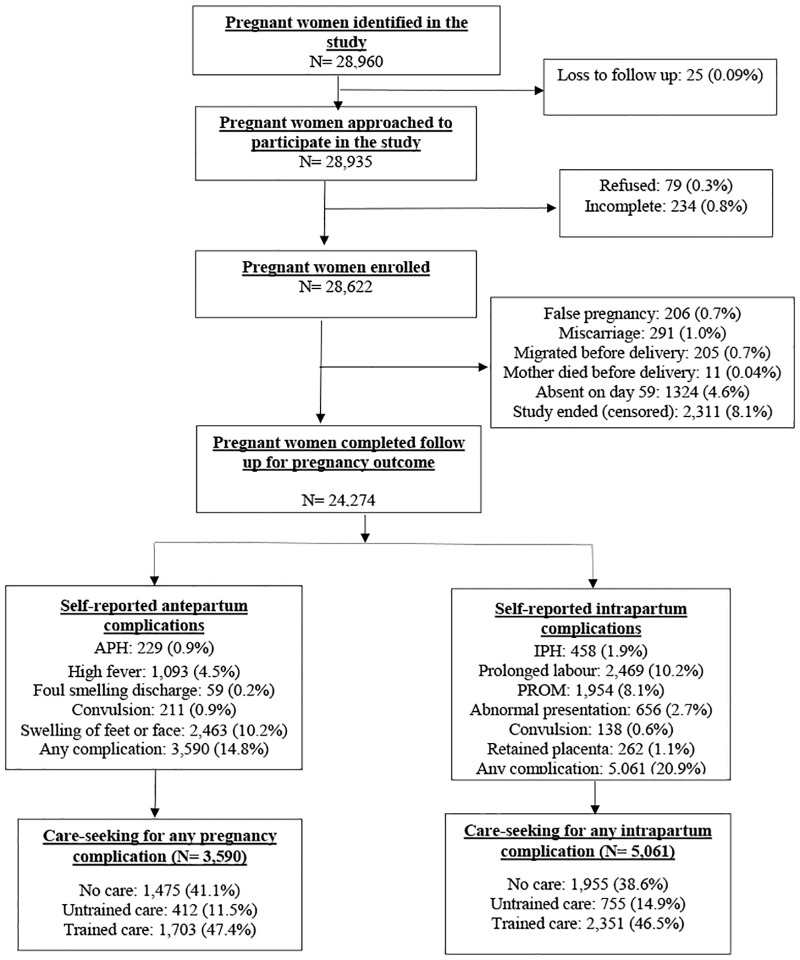
Analytic cohort of pregnant women, maternal complications and care seeking for complications.Note: APH: antepartum hemorrhage; IPH: intrapartum hemorrhage; PROM: premature rupture of membrane. Untrained care: care from community health worker; traditional birth attendant; village doctor; homeopath; or spiritual healers; trained care: care from doctor or a nurse or a midwife or a paramedic.